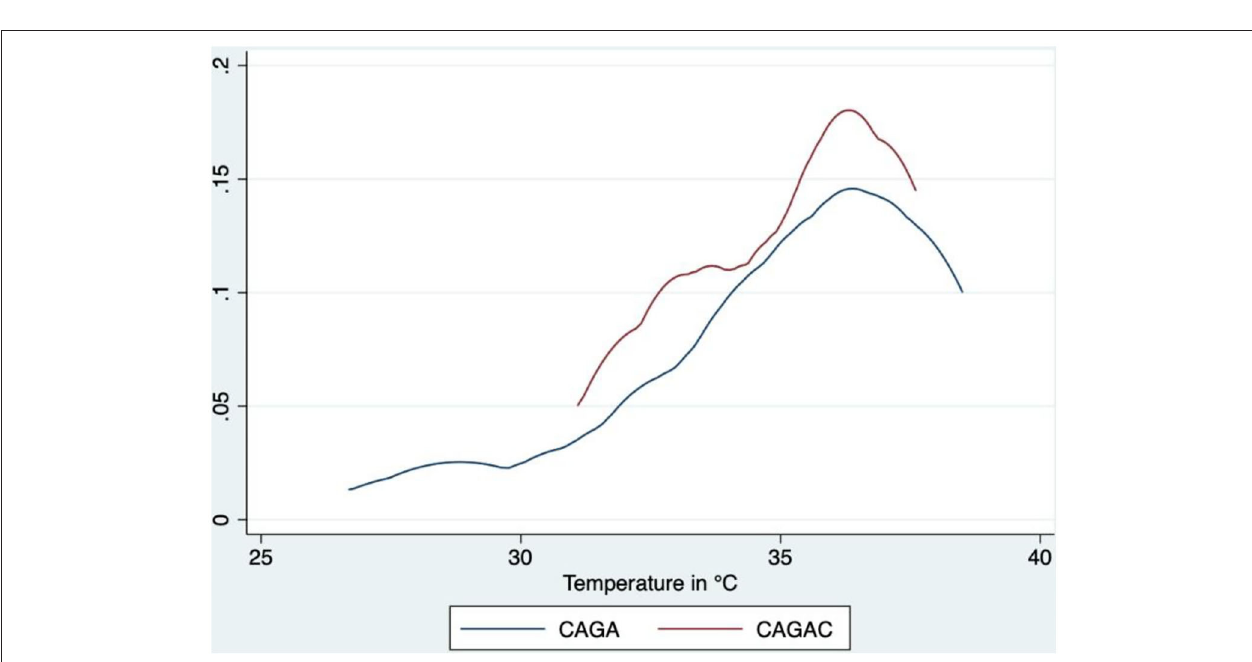
FIGURE 3 | Comparative analysis of probability density functions—SpT. CAGA, circumanal gland adenoma; CAGAC, circumanal gland adenocarcinoma.